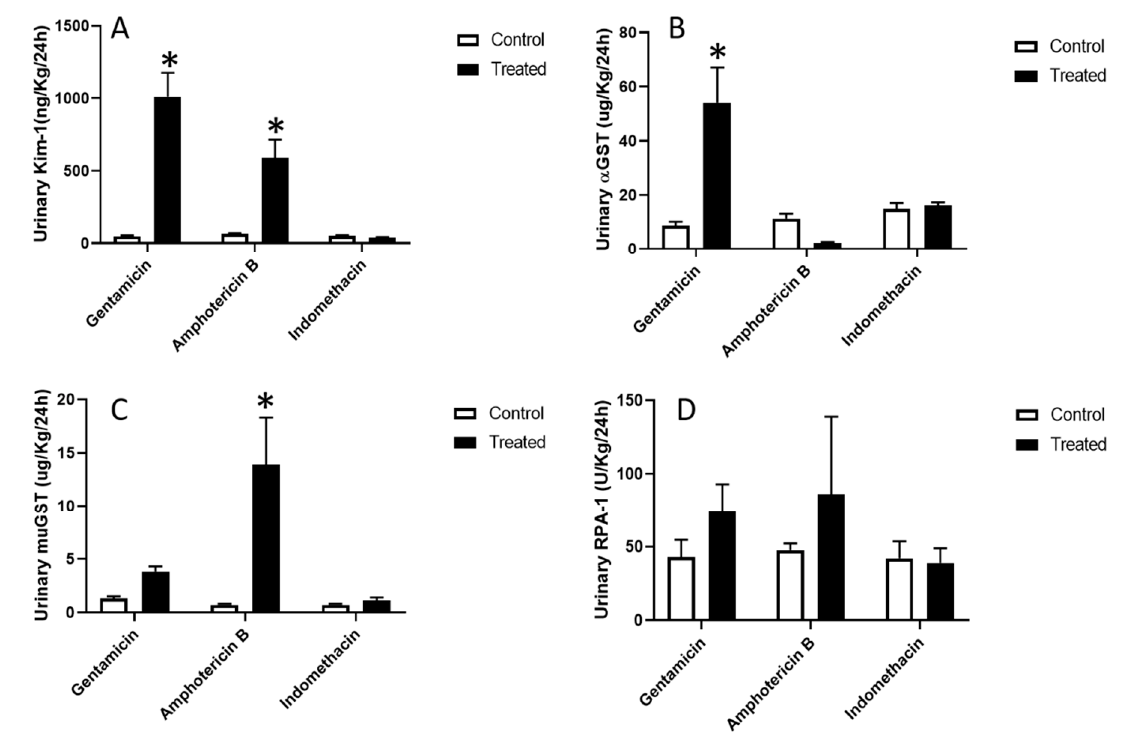
Figure 3. Changes in urinary biomarkers following exposures to site specific nephrotoxicants. Male Sprague/Dawley rats were treated with a proximal tubule nephrotoxicant (gentamicin 100 mg/Kg/day i.p. for 8 days) a distal tubule toxicant (amphotericin B 15 mg/Kg/day i.p. for 5 days) and collecting duct nephrotoxicant (indomethacin single dose 20 mg/Kg p.o.). Control animals were treated